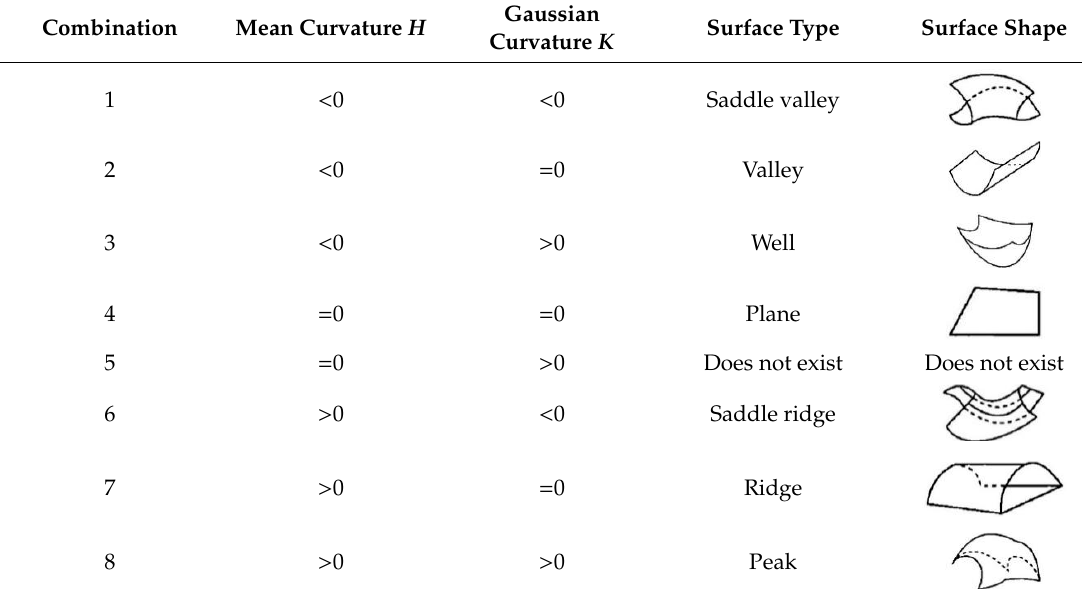
( b ) Figure 9. Schemes of adult Qinchuan cattle: ( a ) Five body dimensions; ( b ) Positions of feature points to be automatically